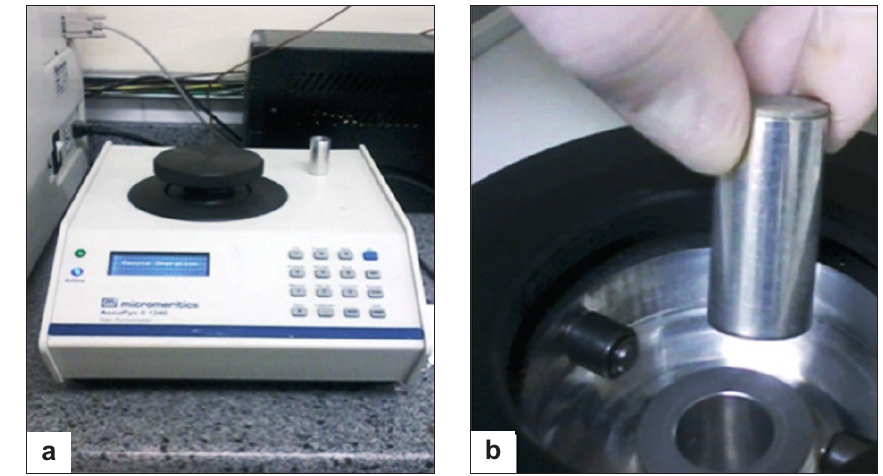
Figure 2 Helium gas pycnometer (a) equipment used; (b) sample chamber